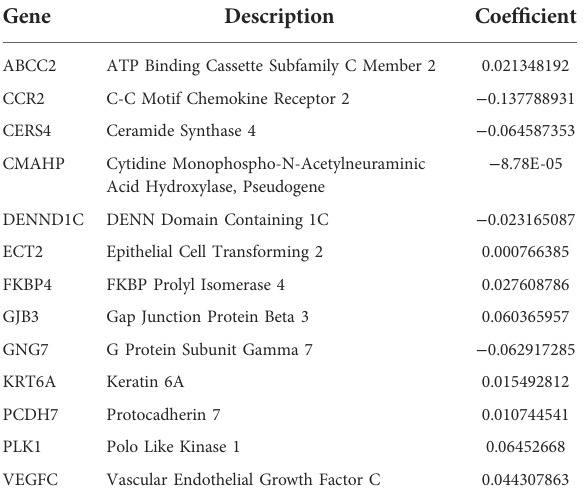
TABLE 2 Thirteen prognostic genes generated from the LASSO Cox regression.